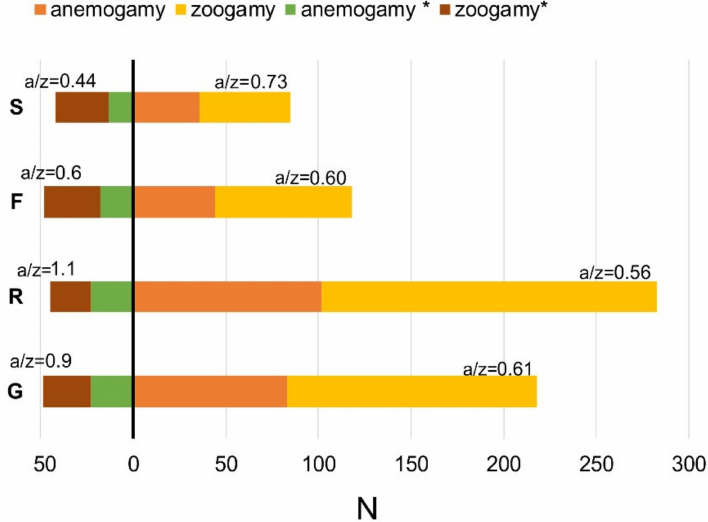
Figure 7. Number of all species pollinated by wind and insects, pollinated by wind and insects among the frequently occurring species (*), and the proportion between these two categories of species (S—open swimming pools, F—multi-media fountain, R—reservoir, G—gravel pit